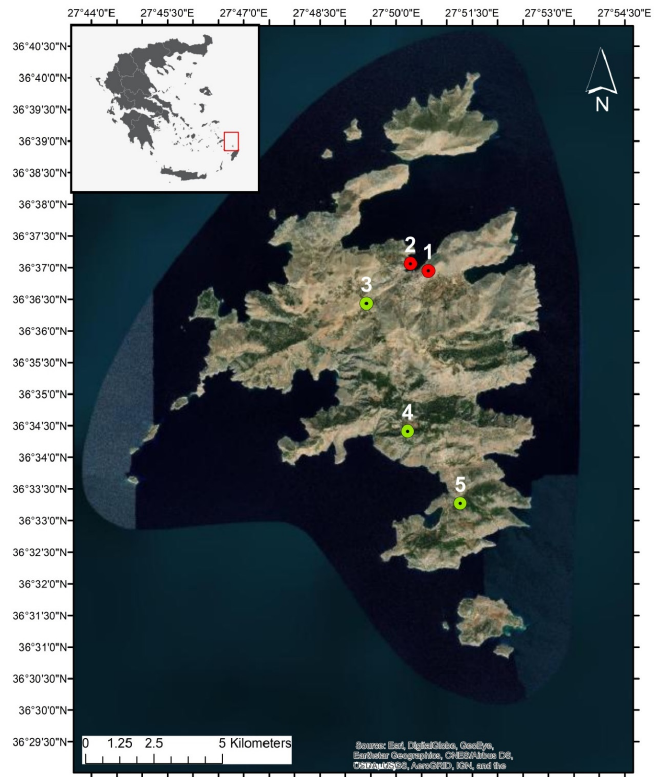
Figure 1. Location of the study area and the different study sites where samples were collected from historical timber (red dots) and living trees (green dots): (1) windmills, (2) doors and imported timber, (3) valonia oak woodland, (4) Cypress forest, and (5) Turkish pine forest.